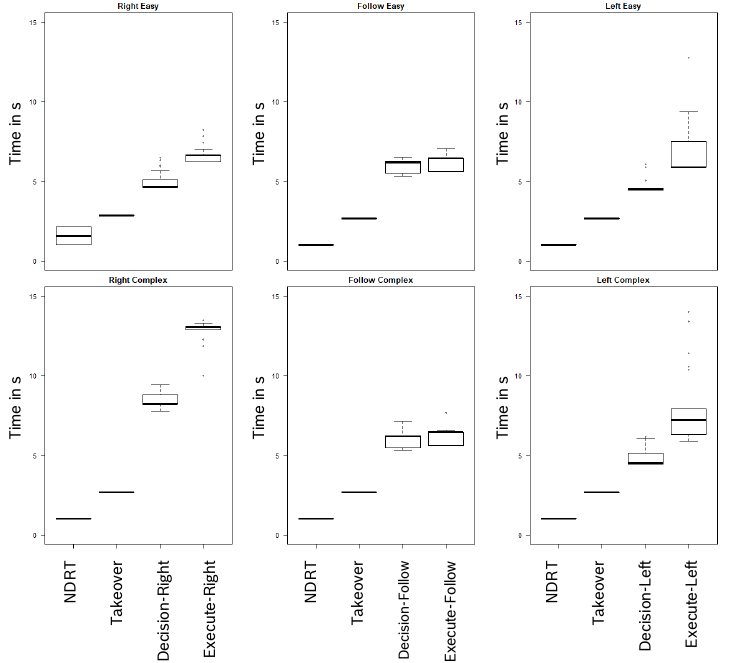
Figure 6. Box-whisker plot of model predictions for each task in each condition. The y-axis shows the timeline in seconds (s) including the NDRT, the takeover, the corresponding action decision, and the action execution (source: own figure). Table 1. Predicted time statistics of the cognitive model with a lane-change right maneuver. Repre- sentation of minimum (Min), mean, and maximum (Max) values over N = 60 trials. Wrong decisions are in lower case letters (source: own